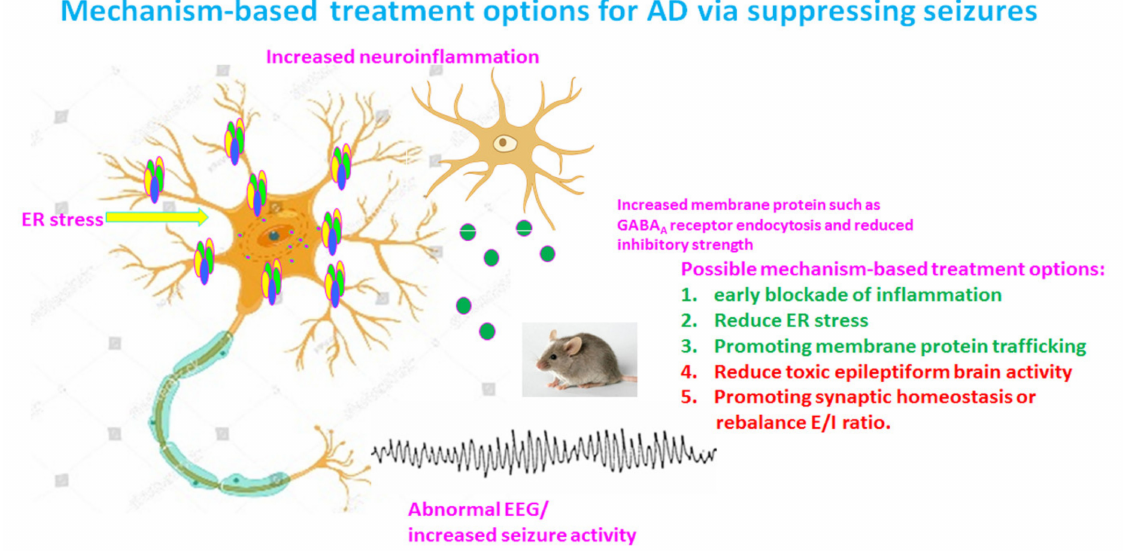
Figure 2. Potential mechanism-based treatment options for Alzheimer’s disease (AD) via suppressing toxic epileptiform discharges. There are multiple pathologies in a chronic disease state such as AD. In addition to the established amyloid hypothesis and tauopathy, pathological features for AD likely also include increased neuroinflammation, endoplasmic reticulum (ER) stress, impaired protein membrane trafficking, and increased toxic epileptiform discharges due to altered brain excitation and inhibition (E/I) balance. Therefore, any pharmacological or genetic approaches that can block neuroinflammation, reduce ER stress, promote vesicular protein trafficking, or correct E/I imbalance would be beneficial and disease modifying for